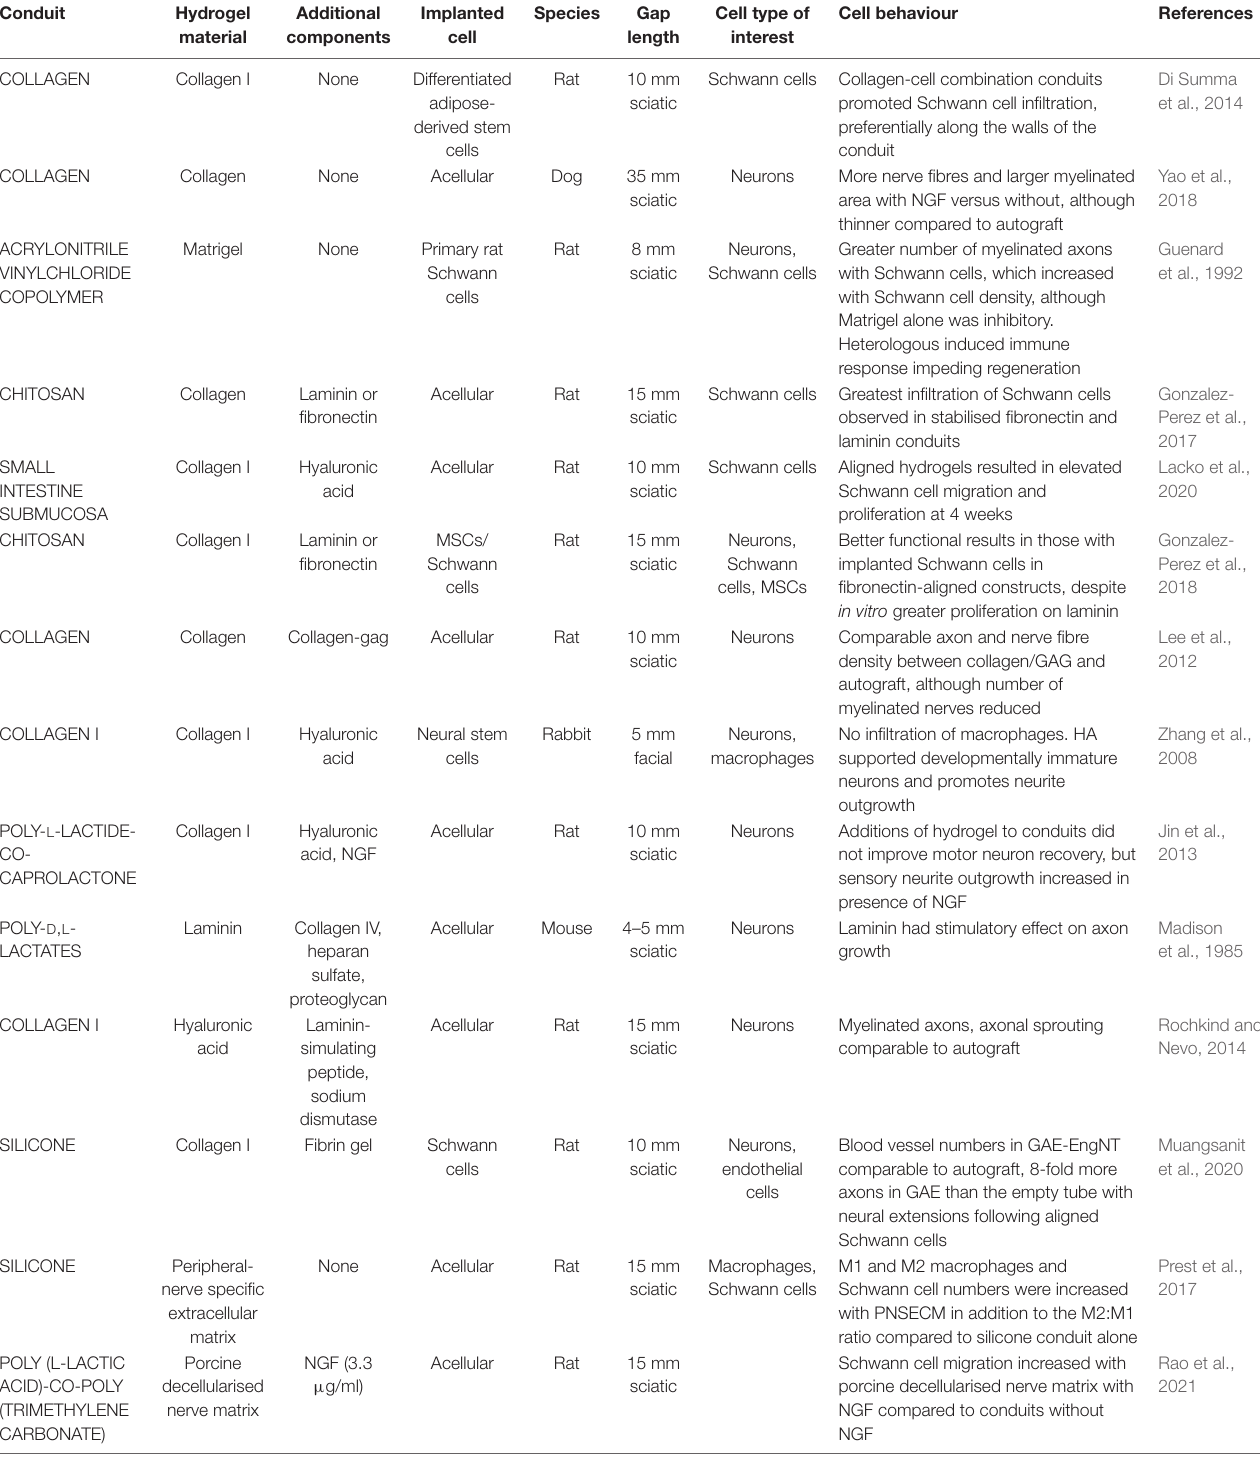
TABLE 1 | Summary of extracellular matrix hydrogels as nerve guidance conduit luminal fillers in in vivo models.